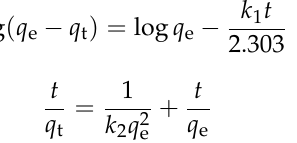
where q e and q t (mg g − 1 ) are the adsorption capacity at equilibrium and at any time ( t ; min), respectively. k 1 (min − 1 ) is the pseudo-first-order rate constant and k 2 (g mg − 1 min − 1 ) is the pseudo-second-order rate constant. The kinetic parameters and the correlation coefficients (R 2 ) obtained by linear regression are listed in Table